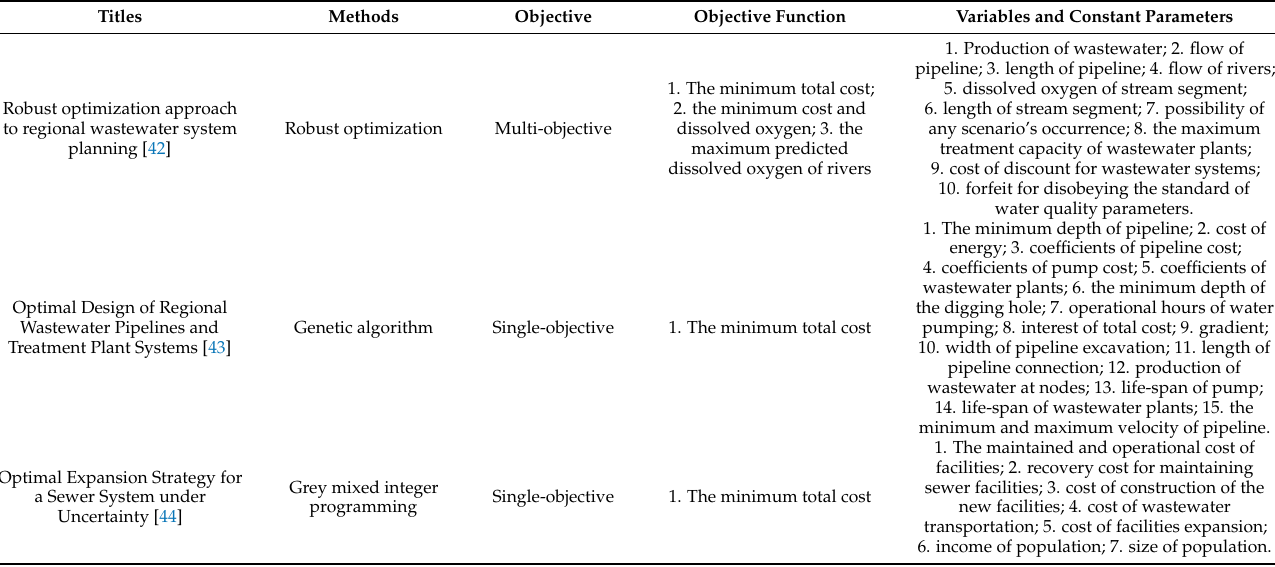
Table 3. Comparison of available studies related to sewer system